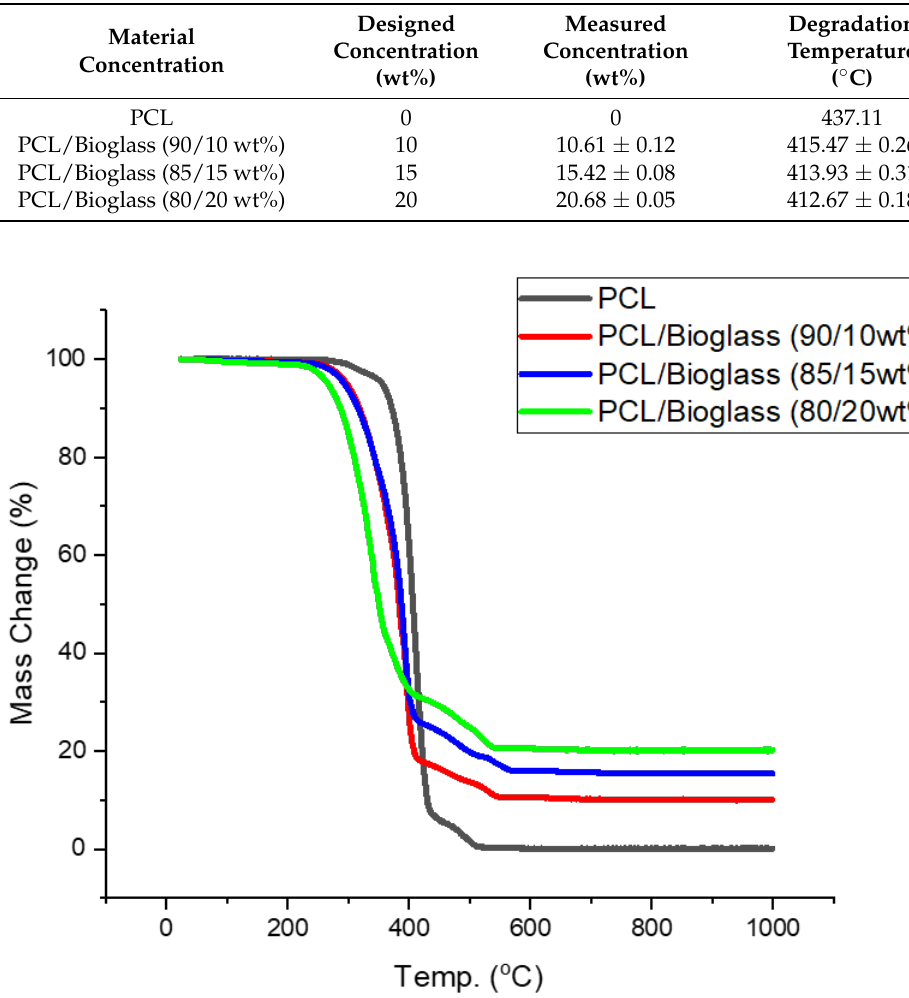
Figure 7. The Thermal Gravimetric Analysis (TGA) curves of the bioglass bone bricks.